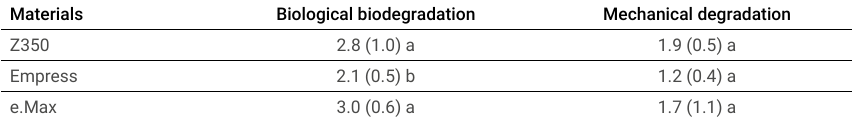
Groups denoted by a different letter represent significant difference